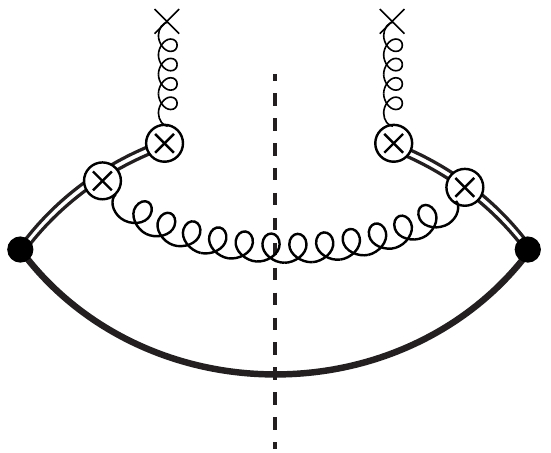
Figure 3 . One-loop Feynman diagram for the logarithmically divergent contribution to E 10;10 . The symbol ⊗ is the chromoelectric field, and symbol × represent contributions from nonperturba- tive/external gluon